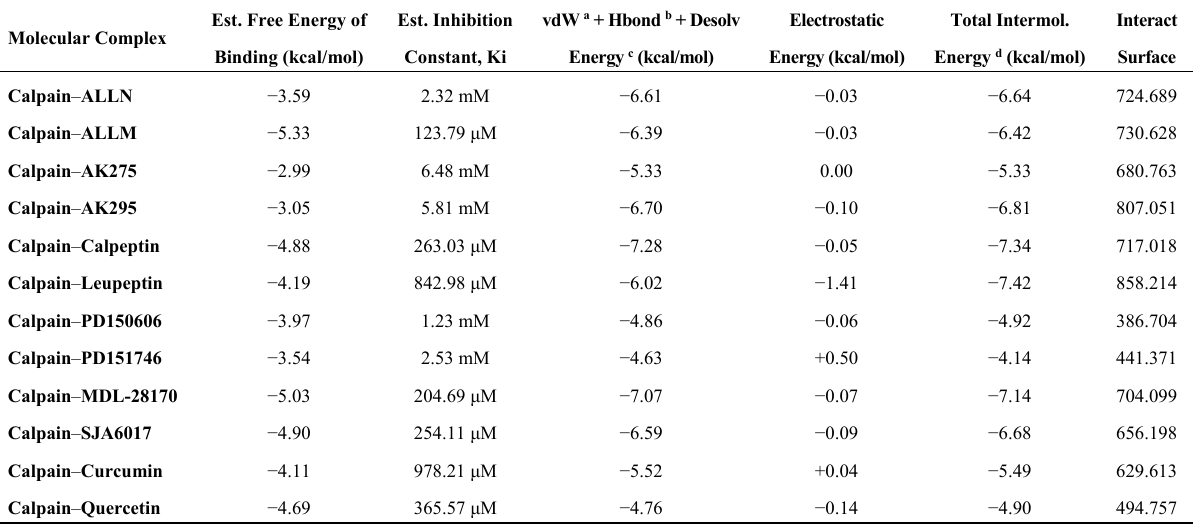
Table 3. Estimated free energies of binding, constituent energies, calculated inhibition constants [Ki (calculated)], and interaction surface of the studied inhibitors after docking into the proteolytic site of